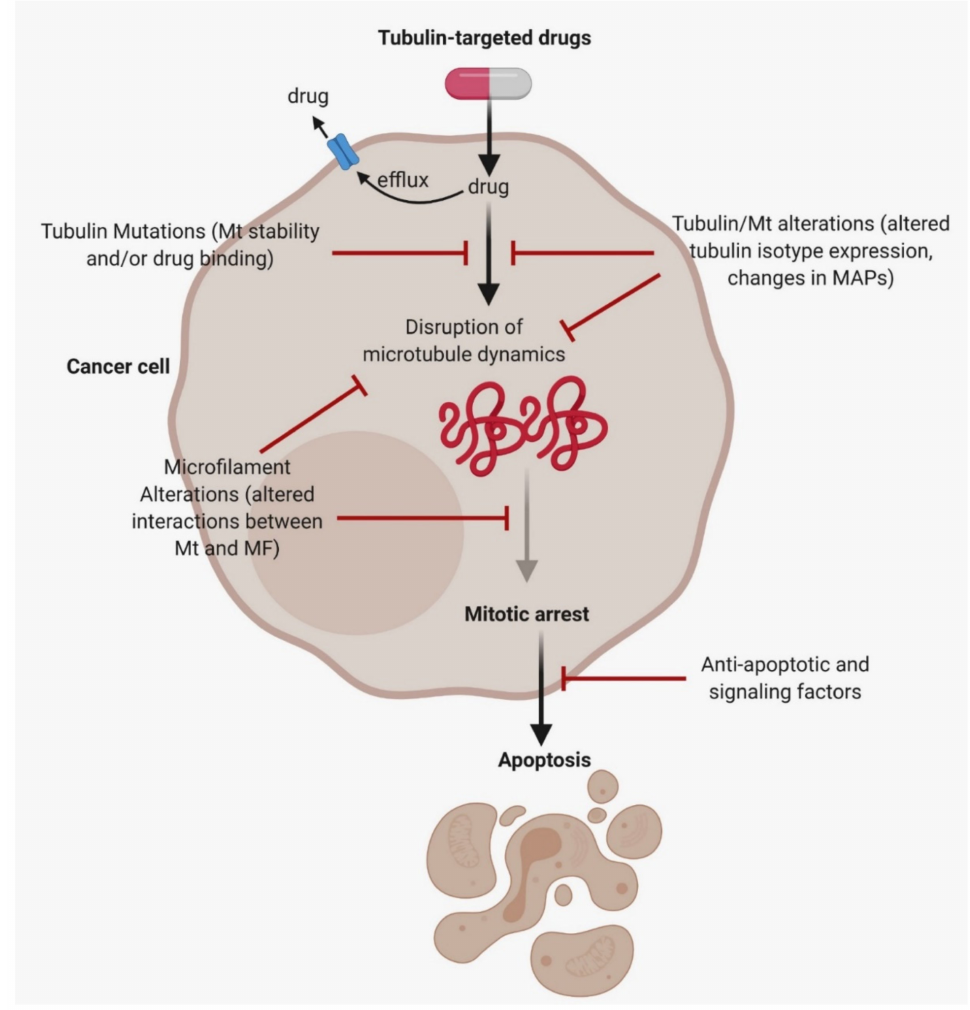
Figure 3. A schematic diagram illustrating the resistance mechanisms associated with anti-microtubule drugs. These drugs cross the lipid bilayer of the cell membrane and then bind themselves to β -tubulin to alter the microtubule dynamics, causing mitotic arrest and consequent apoptosis. Drugs can be